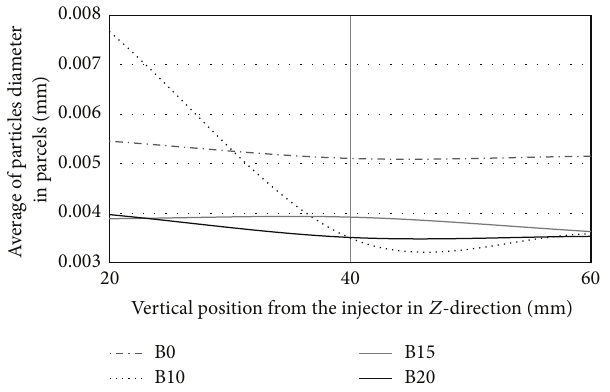
Figure 23: Average velocity in 𝑍 -direction for different HFO/n- butanol blends at injection pressure of 1000bar on different vertical positions from the